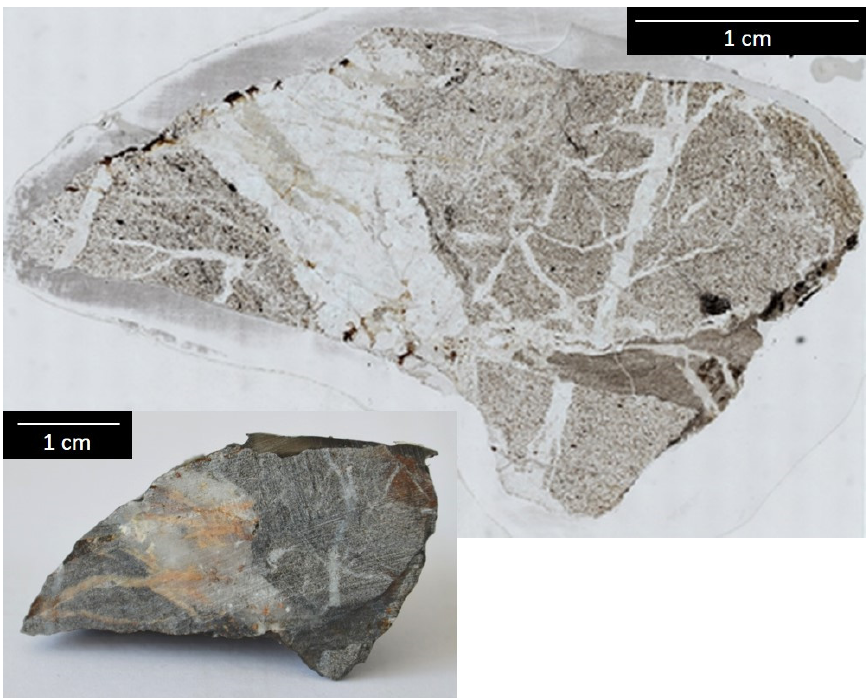
Figure 2. Main petrographic features of the studied sample. General view of the shale sample and of the thin section, on which the veins can be seen in white through the shale in grey (natural light).